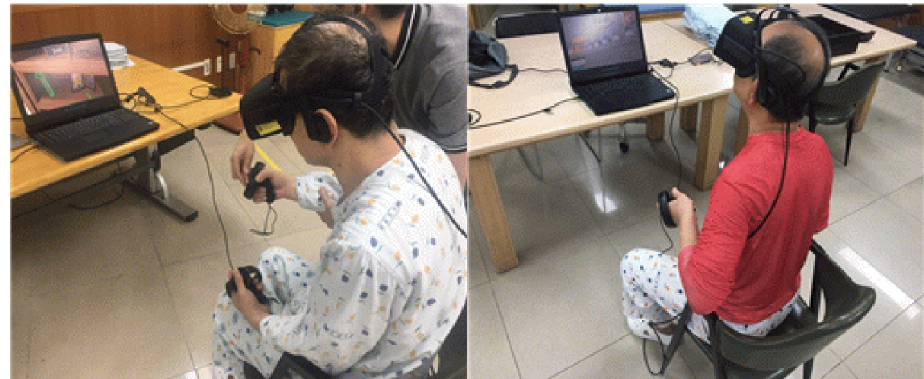
Figure 3. Intervention in the virtual reality-based bilateral arm training group.